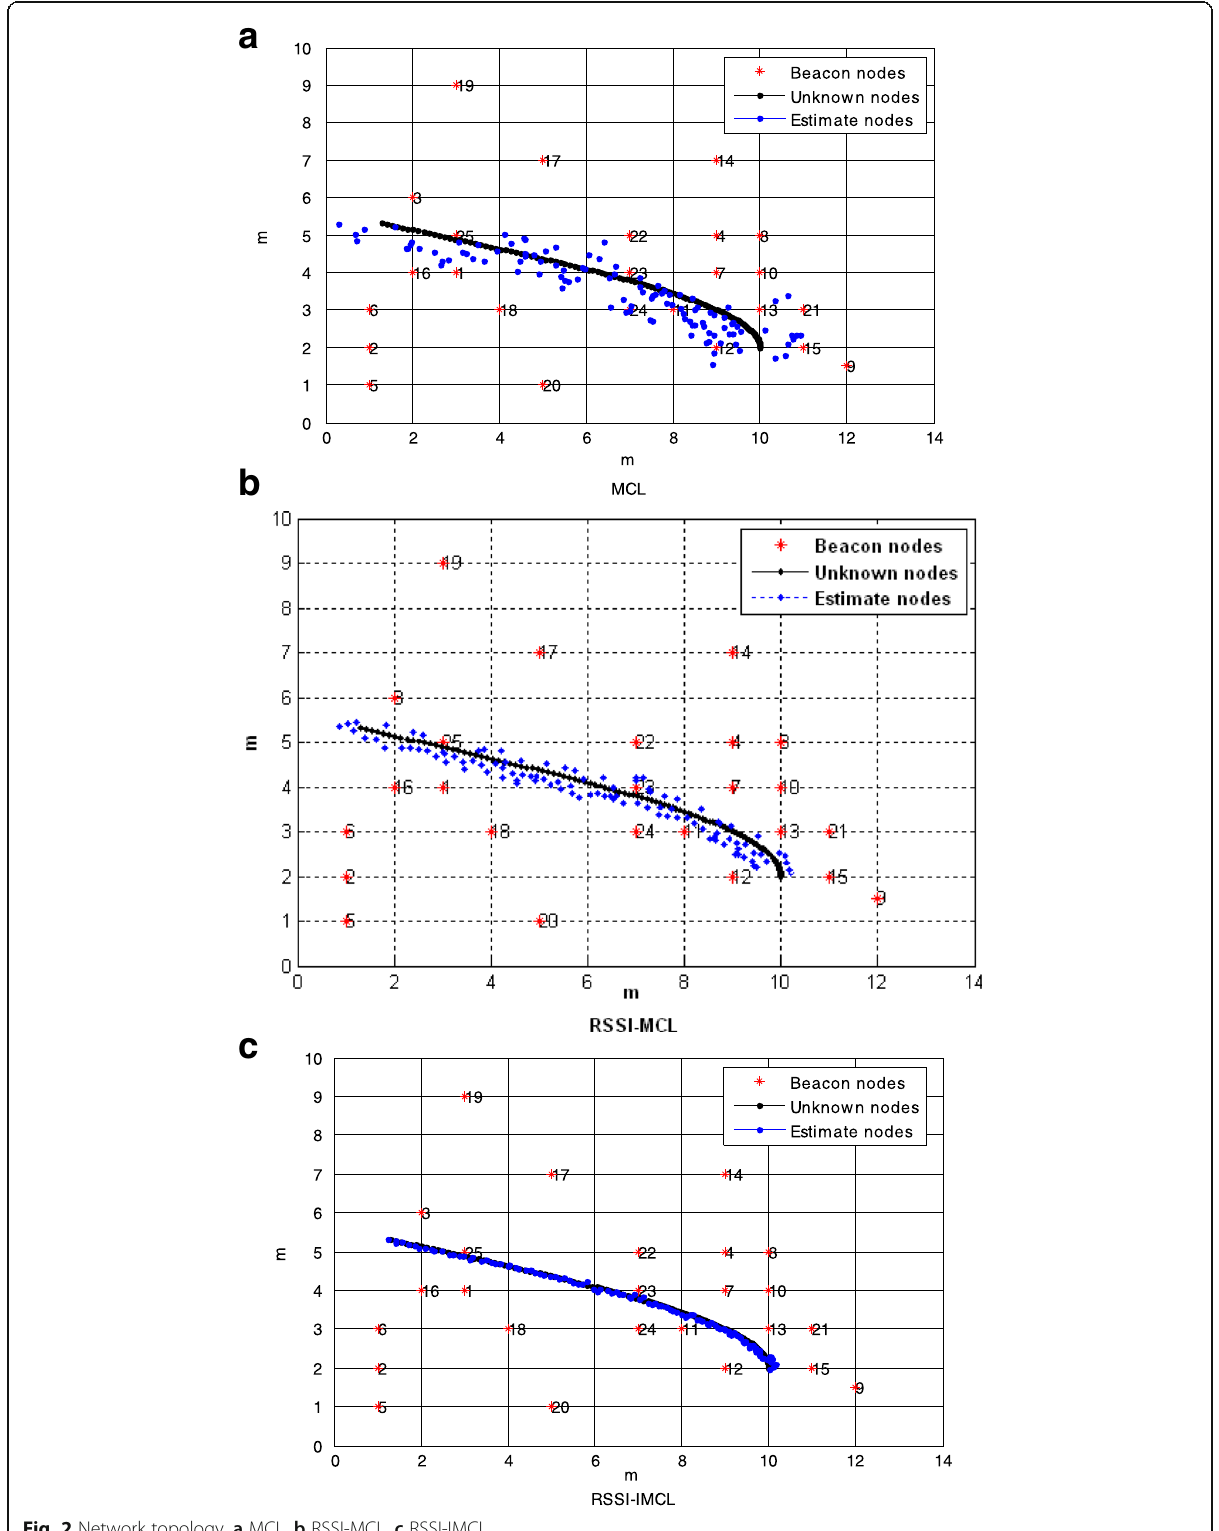
Fig. 2 Network topology. a MCL. b RSSI-MCL. c